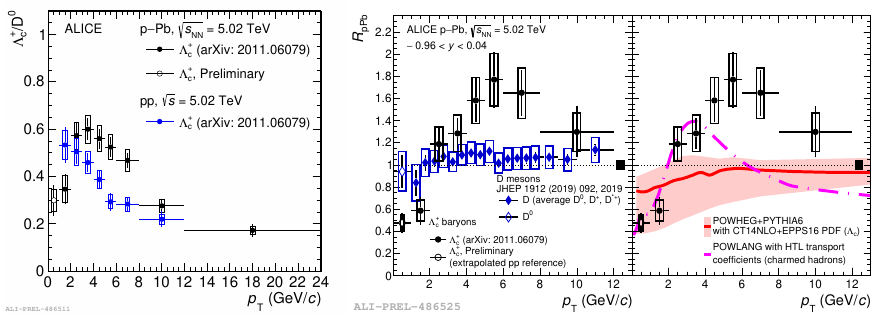
Figure 3. Left: The Λ + c / D 0 ratio as a function of p T measured in pp collisions and p–Pb collisions at 5.02 TeV [7]. Right: The nuclear modification factor R pPb of the Λ + collisions at √ s NN = 5 . 02 TeV, compared to R pPb of D mesons, as well as to model expectations